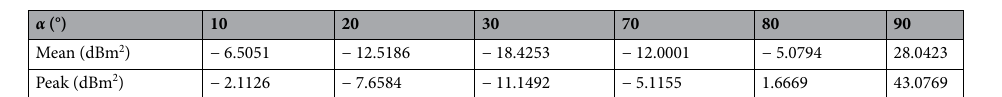
Table 7. RCS indicator of the aircraft, β = 0°, f RH = 6 GHz, ω m1 = ω m2 = 0.1963 rad/s, t = 0 ~ 4.407 s.